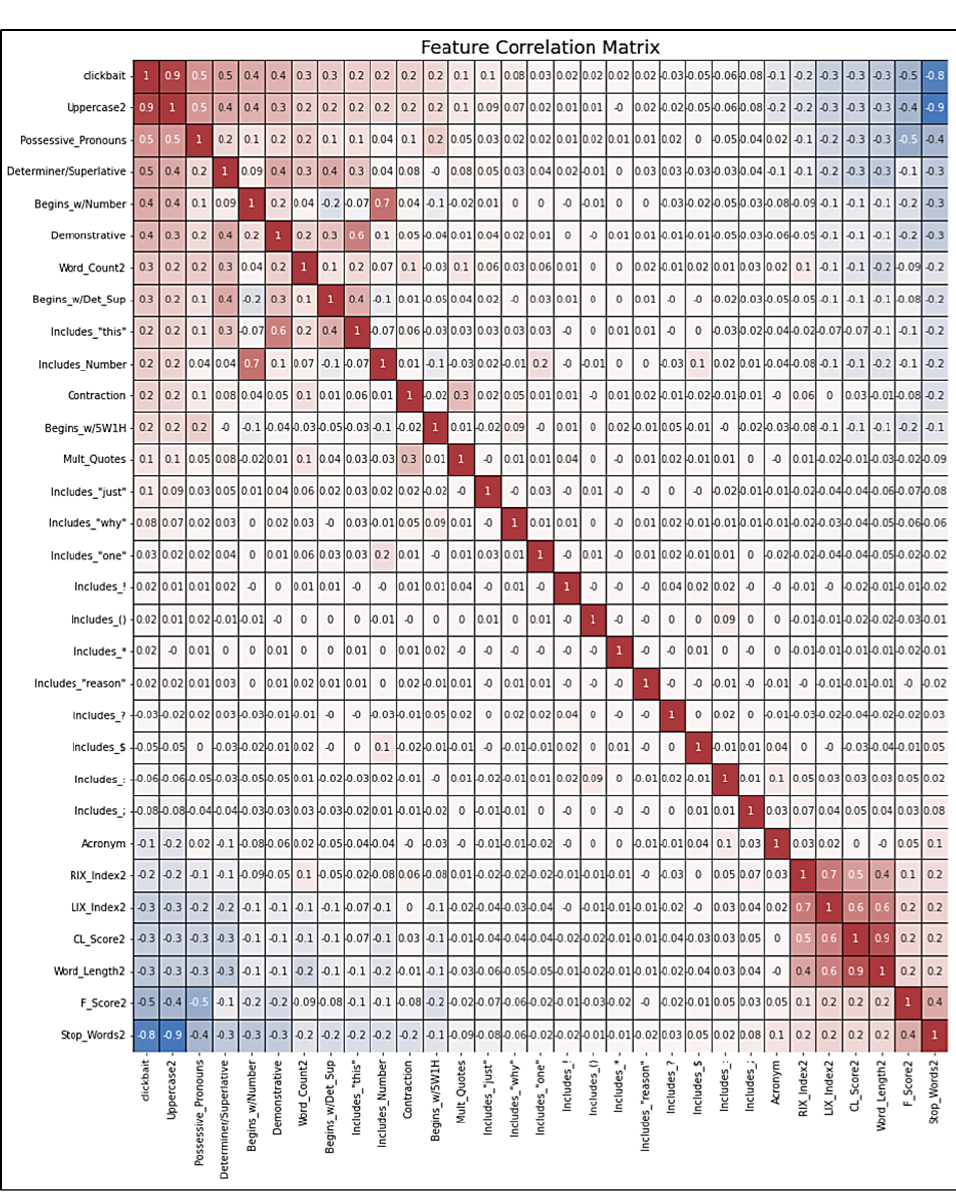
Figure 3. Feature Correlation Matrix. Overall, the feature correlation +/ − groupings in the matrix match the predicted clickbait/non-clickbait associations in the stacked bar charts. There are two features that have very high correlation values. The feature “Uppercase2” has a coefficient of correlation of 0.9, which is an almost perfect correlation with the clickbait target classification. On the other end of the spectrum, the feature “Stop Words2” has a coefficient of correlation of − 0.8, which indicates a very strong correlation with a non-clickbait target classification. Table 3 contains a listing of the 15 features with the highest correlation